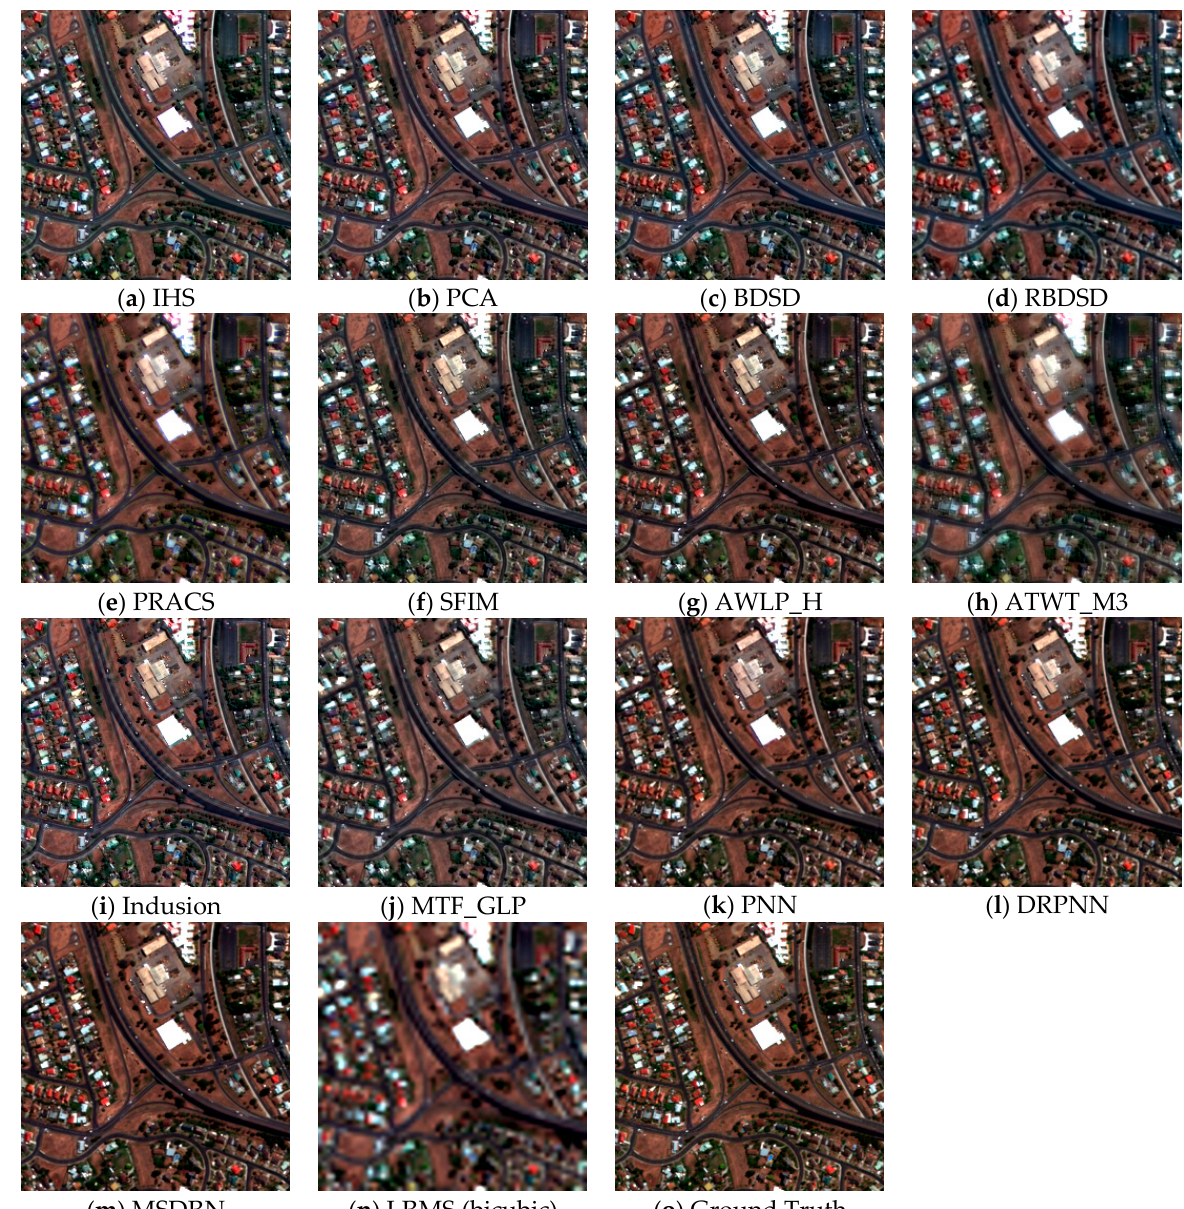
Figure 6. An example of simulated experiments on the GeoEye-1 dataset. From ( a – o ) IHS, PCA, BDSD, RBDSD, PRACS, SFIM, AWLP_H, ATWT_M3, Indusion, MTF_GLP, PNN, DRPNN, MSDRN, LRMS (bicubic), Ground Truth.